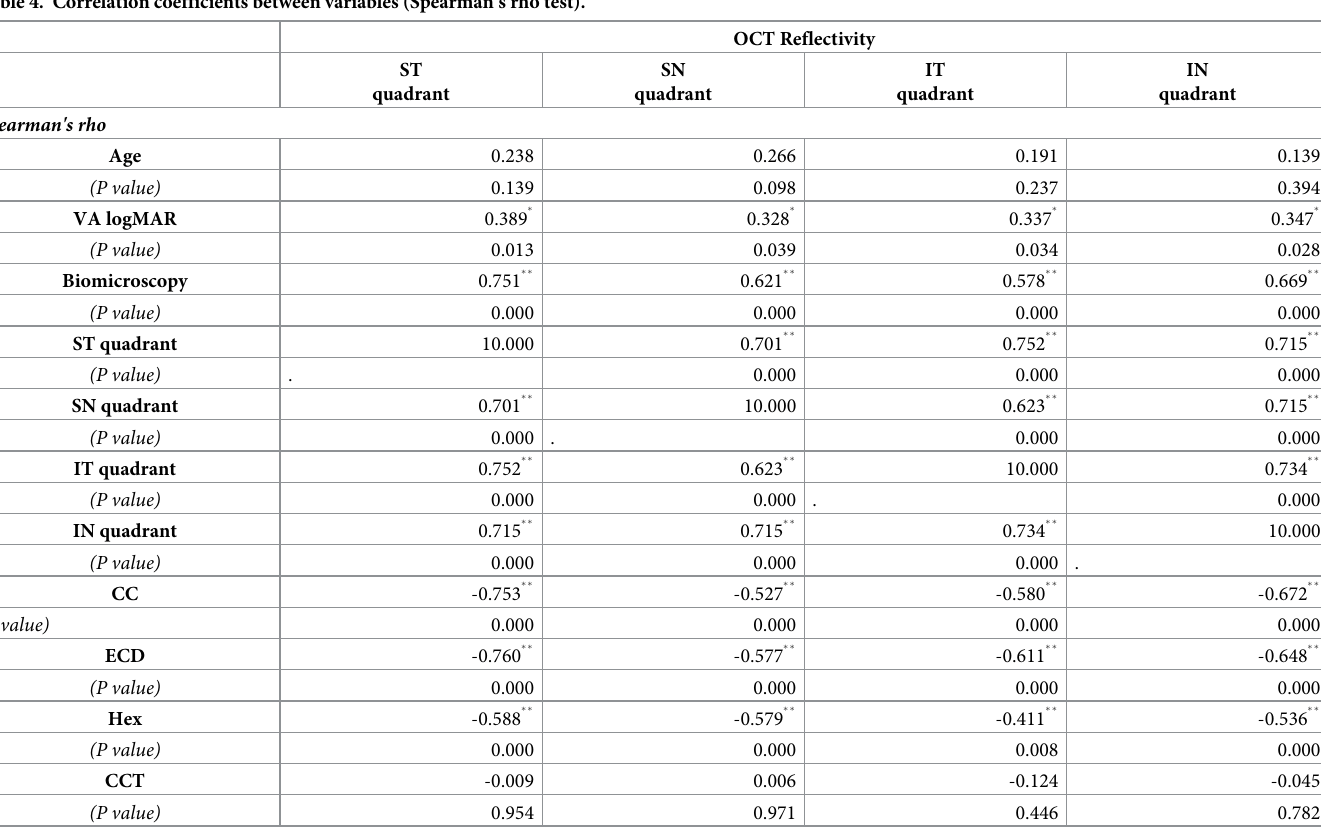
Table 4. Correlation coefficients between variables (Spearman’s rho